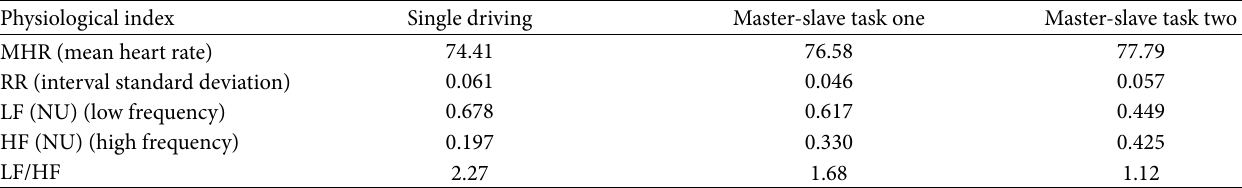
Table 3: Average of ECG index